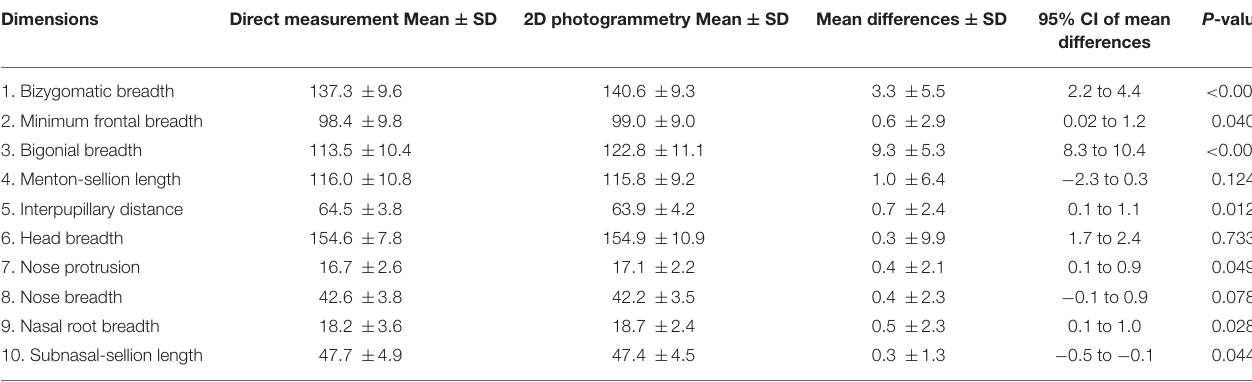
2D Photogrammetry vs. Direct Measurement